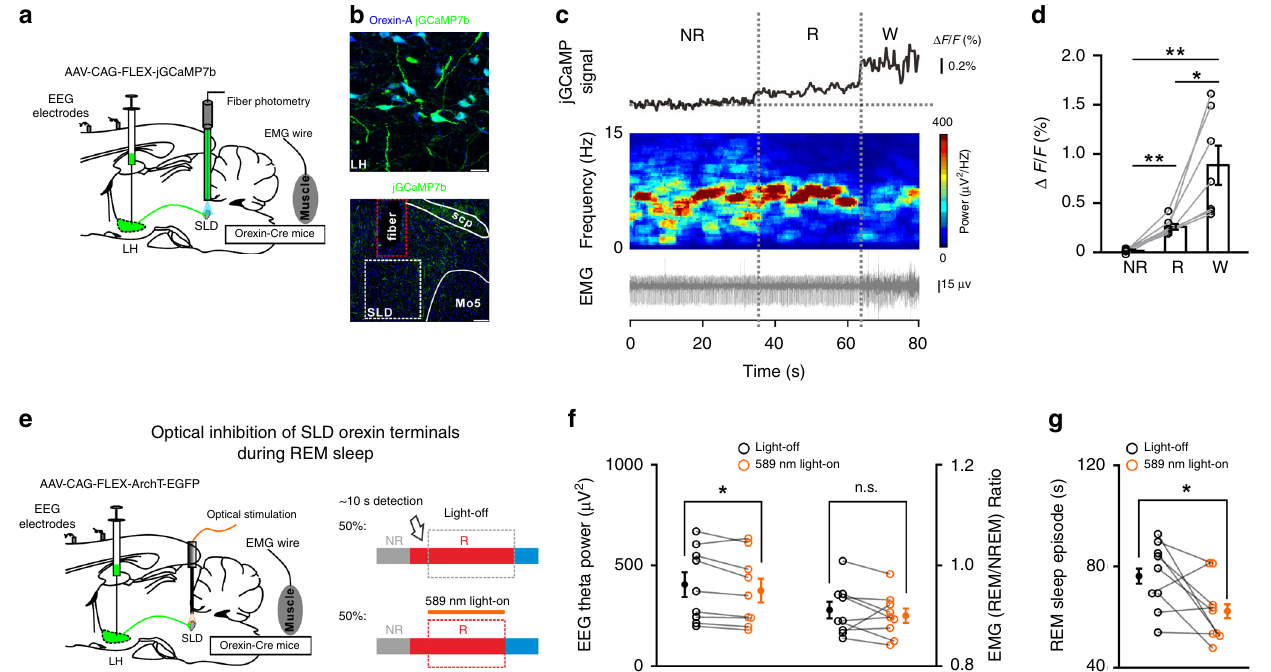
Fig. 7 Optogenetic inhibition of SLD orexin signaling shortens REM sleep bouts. a Schematic drawing of fi ber photometry recordings in the SLD orexin terminals. b Representative viral infections of jGCaMP7b (green) in the LH orexin-A + neurons (blue) (top, scale bar: 25 μ m), and optical fi ber location above the SLD orexin terminals (bottom, scale bar: 100 μ m). c Representative jGCaMP fl uorescence traces of the SLD orexin terminals, spectrogram of EEG recordings, and raw EMG recorded simultaneously in a episode of REM sleep (R), the preceding NREM sleep (NR), and the following wakefulness (W). d Averaged changes of jGCaMP fl uorescence in REM sleep, the preceding NREM sleep, and the following wakefulness ( n = 7 mice; one-way repeated- measures ANOVA; F (2, 12) = 16.758, P = 3.358 × 10 − 4 ; post hoc LSD comparison test; REM vs. NREM: P = 2.481 × 10 − 4 ; wake vs. NREM: P = 4.563 × 10 − 3 ; REM vs. wake: P = 0.0127). e Schematic drawing for optogenetic inhibition of the SLD orexin terminals (left) and procedures for closed-loop optogenetic inhibition during REM sleep (right). The EEG/EMG signals were visually inspected on-line. Lasers were manually turned on with 50% probability after the detection of REM sleep (~10 s), and turned off when the REM sleep episode ended. f Effects of optical inhibition of the SLD orexin terminals during REM sleep on the EEG theta power (left, two-sided paired t -test; t 8 = 2.582; P = 0.0325) and EMG REM/NREM ratio (right, two-sided paired t -test; t 8 = 1.060; P = 0.320) ( n = 9 orexin ArchT mice). g Effects of optical inhibition of the SLD orexin terminals during REM sleep on the episode duration of REM sleep ( n = 9 orexin ArchT mice, two-sided paired t -test; t 8 = 2.512; P = 0.0363). Data represent mean ± SEM. * P < 0.05; ** P < 0.01. Source data are provided as a